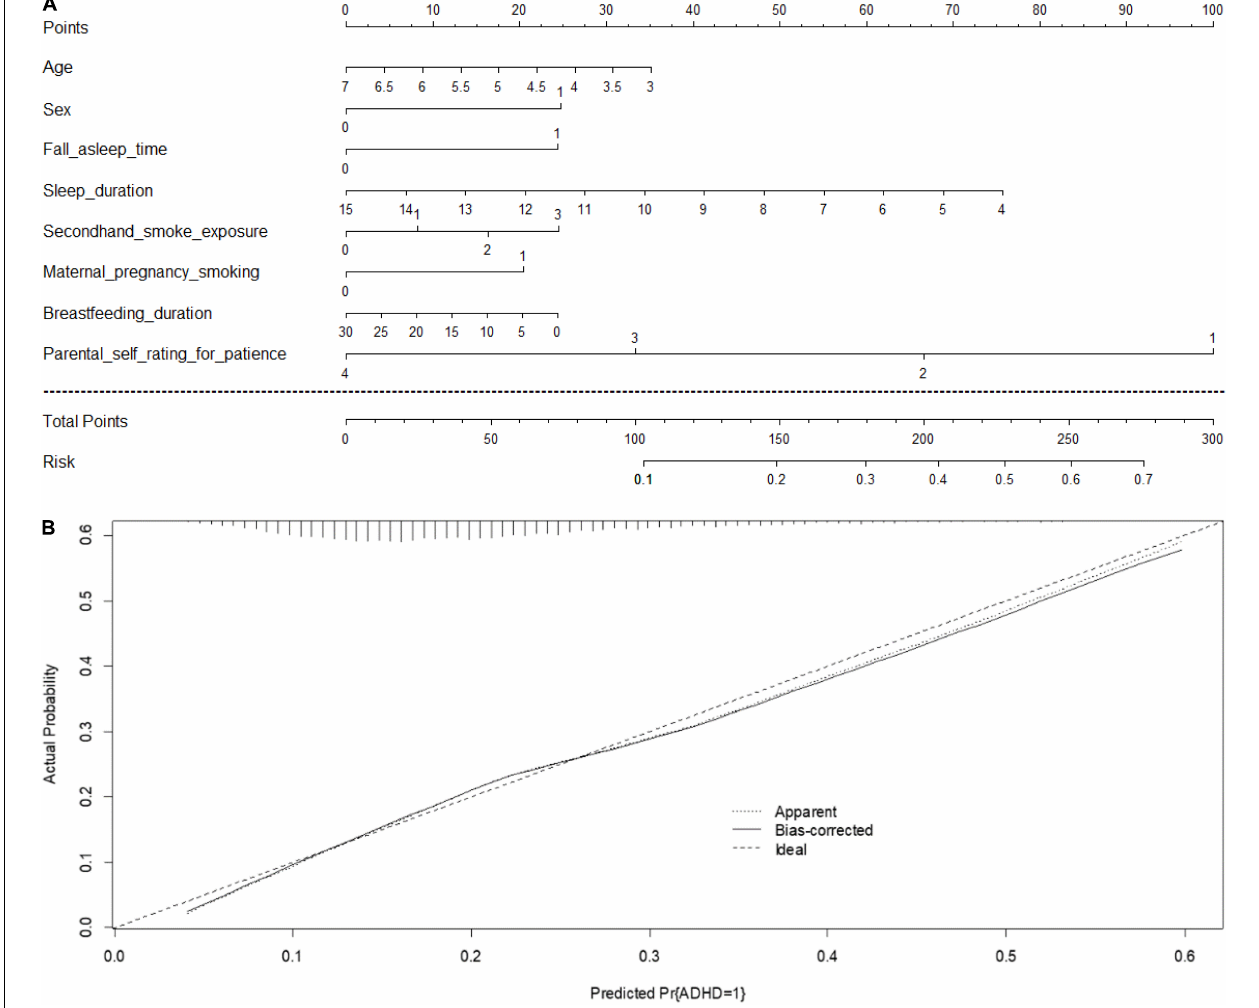
FIGURE 3 | (A) Prediction nomogram for C-ASQ-defined ADHD susceptibility. An individual’s value is located on each variable axis, and a line is drawn upward to determine the number of points received for each variable value. The sum of these numbers is located on the “Total points” axis, and a line is drawn downward to the “Risk” axis to determine the likelihood of C-ASQ-defined ADHD susceptibility. (B) Calculation curves for C-ASQ-defined ADHD susceptibility. Nomogram- predicted probability of C-ASQ defined ADHD susceptibility plotted on the x- axis; actual probability of C-ASQ defined ADHD- susceptibility on the y- axis. The plots depict model performance in terms of agreement between predicted and actual probability of C-ASQ defined ADHD susceptibility. Prediction is represented by the 45 degree